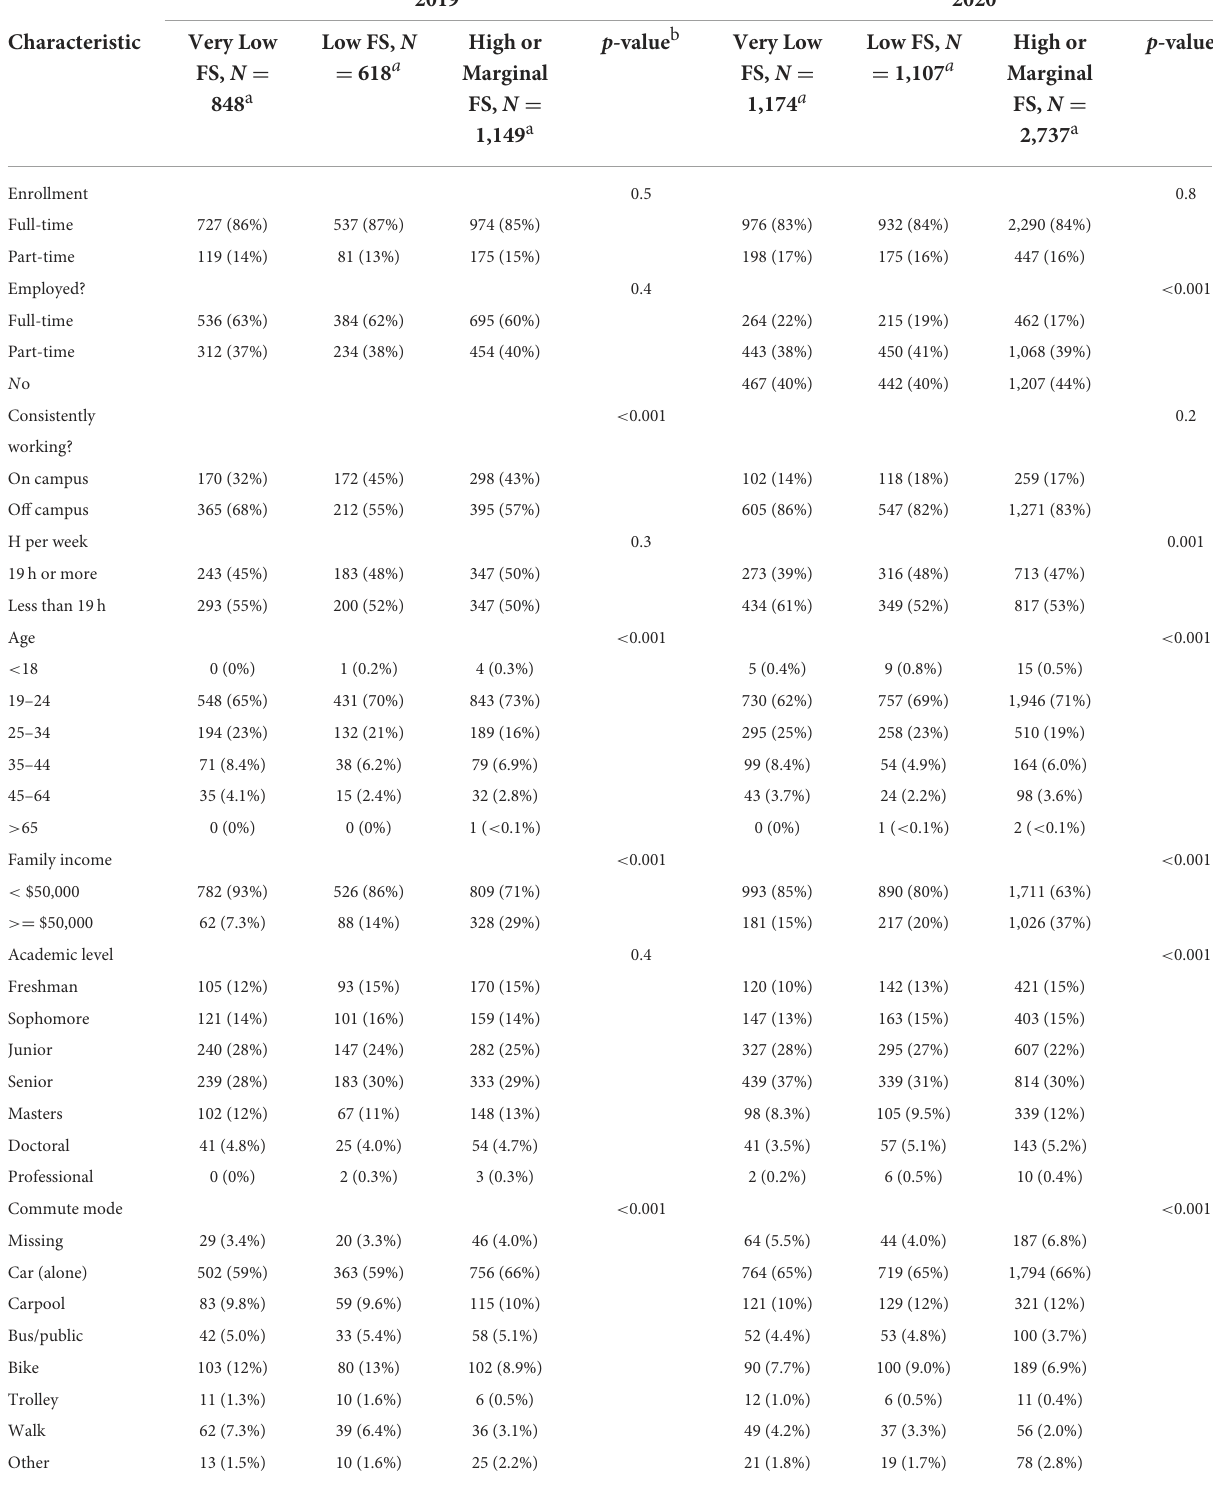
TABLE 2 Factors by year and USDA food insecurity